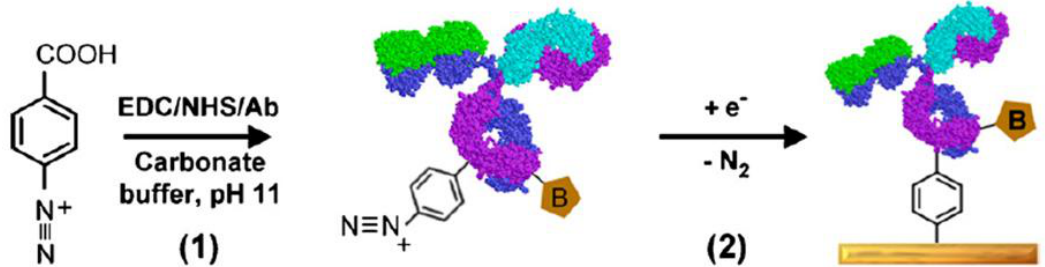
Figure 2. Preparation of a diazonium-modified antibody electrode: carboxyl diazonium is covalently attached to antibody by EDC/NHS (1) and diazonium–antibody is deposited onto an electrode by cyclic voltammetry (2). Reprinted and adapted from [26] with permission.